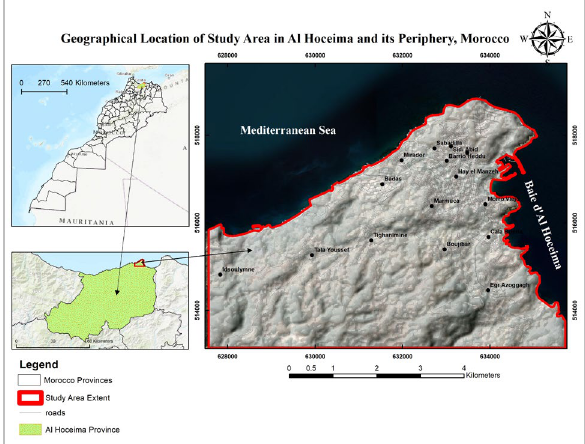
Figure 1. The geographical Location of the study area in Al